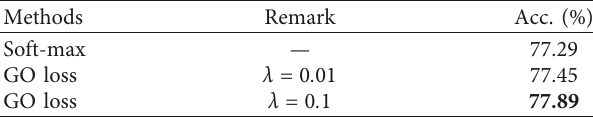
Table 9: Classification accuracy on ImageNet